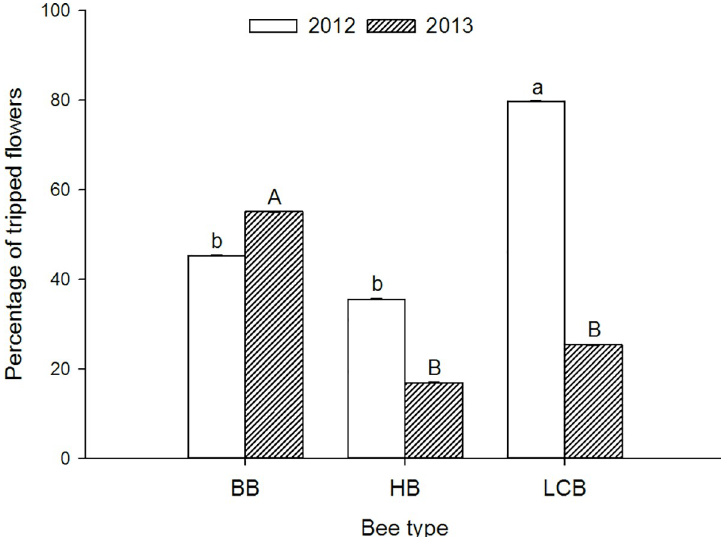
Fig 1. The impact of bee species and year on the tripping rate. The tripping rate is the proportion of flowers visited whose anthers and stigmas were released by a pollinator. Different letters indicate significant statistical differences among bee species with upper or lower case letters used for a given year.